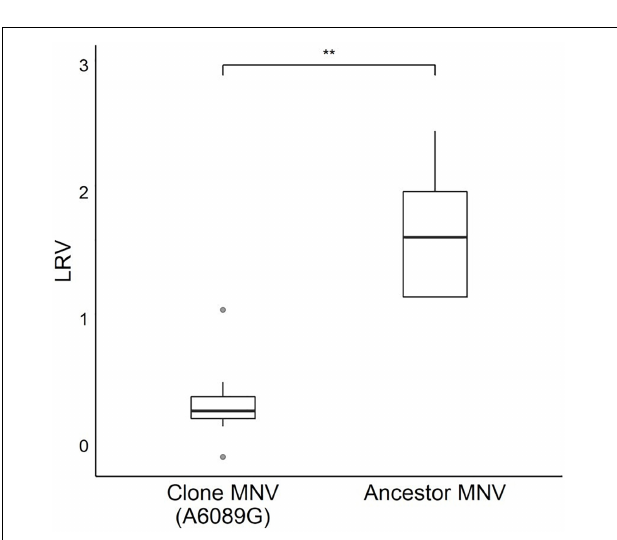
FIGURE 5 | Trajectories of single-nucleotide polymorphisms (SNPs) detected with at least 1% frequency through the serial passage with (+lime) and without ( − lime) treatment in the first (A) and second (B) rounds.